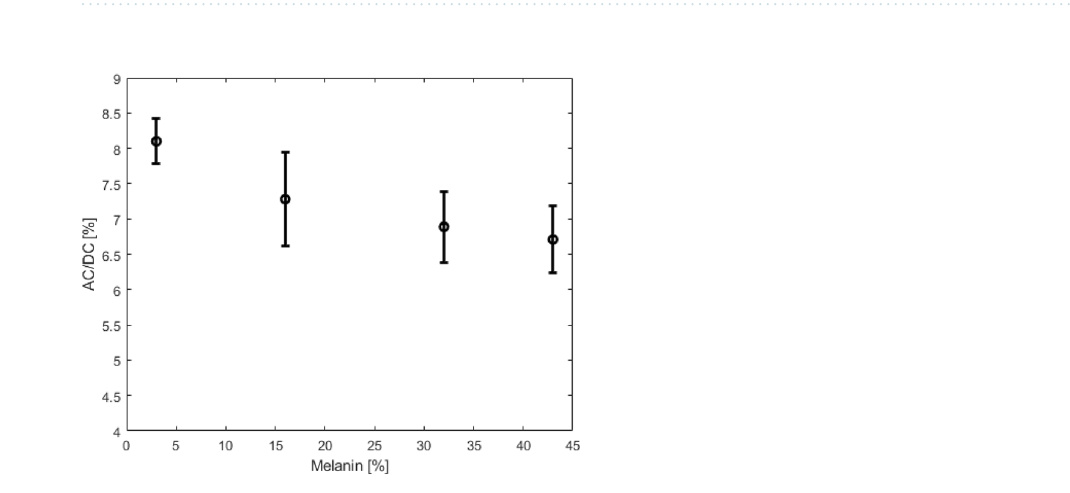
Figure 7. PPG AC/DC ratio change with melanin concentration change in epidermal layer for non-obese